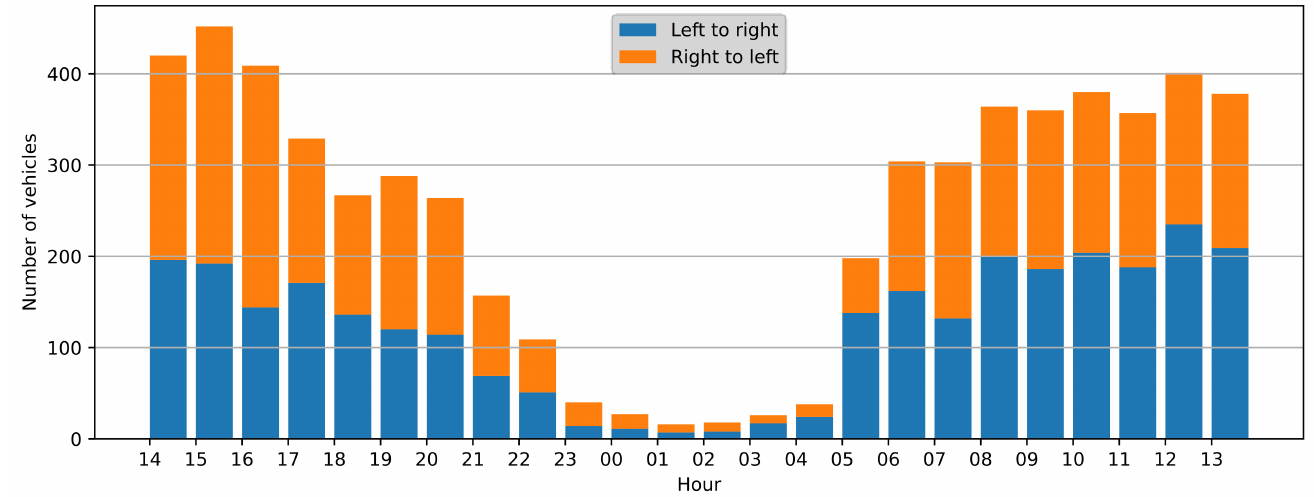
Figure 6. Number of vehicles observed in one-hour time